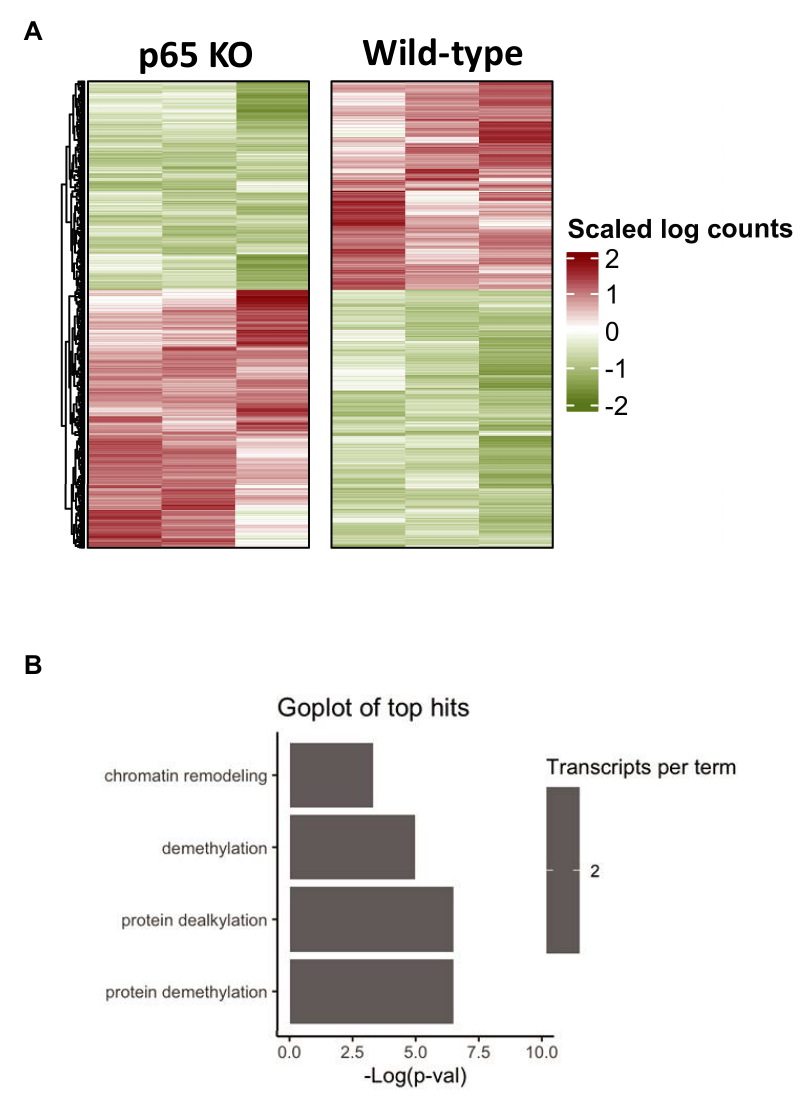
Figure 6. RNA-seq analysis of wild-type and cardiac-specific p65 knockout mice. ( A ) Heat map analysis of NF-κB p65 knockout mice (p65 KO) and wild type mice. ( B ) Top gene ontology terms for genes altered in p65 KO mice compared to wild-type mice.